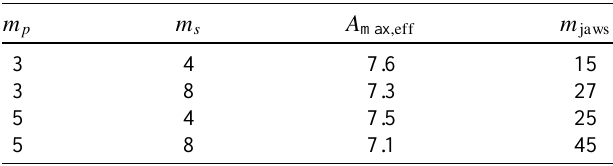
TABLE II. Effective maximum amplitude of the secondary halo (cid:65) max (cid:44)(cid:101)(cid:102)(cid:102) and total number of jaws (cid:109) (cid:106)(cid:97)(cid:119)(cid:115) as a function of the number of primary and secondary jaws (cid:109) (cid:112) and (cid:109) (cid:115) . The primary jaws are arranged to form a regular polygon in the normalized plane (cid:115) (cid:88) (cid:49) (cid:44) (cid:89) (cid:49) (cid:100) . The secondary jaws are arranged to contain the scattering angles inside another regular polygon located in the normalized plane (cid:115) (cid:88) 0 (cid:49) (cid:44) (cid:89) 0 (cid:49) (cid:100) . The betatronic phase advances between primary and secondary jaws are the optimum ones; see text.